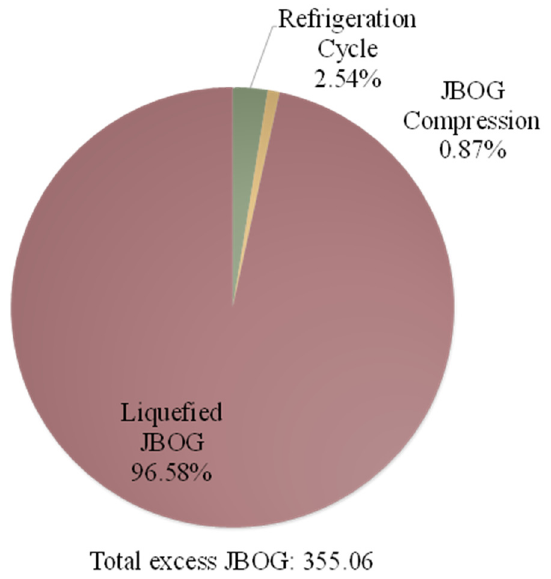
Figure 5. Excess JBOG distribution in JBOG liquefaction scenario.